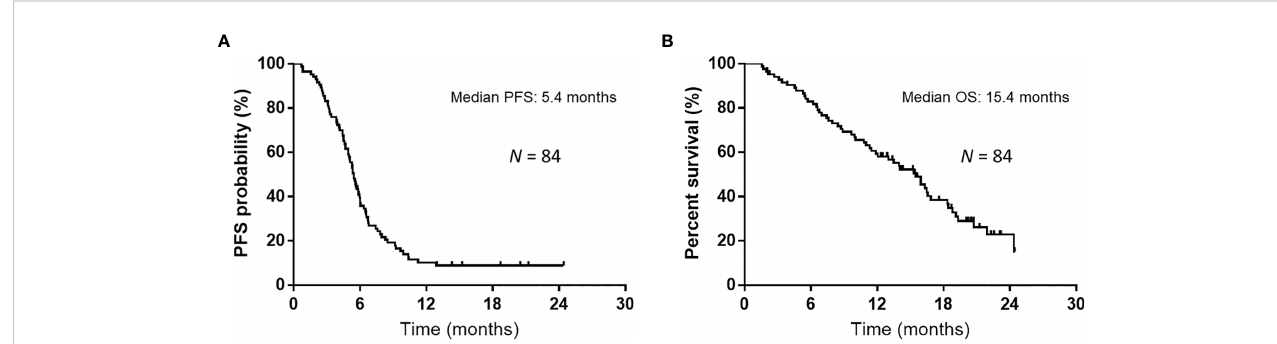
FIGURE 1 Kaplan – Meier curves for progression-free survival (PFS) and overall survival (OS). (A) The median PFS was 5.4 months among all 84 patients who received atezolizumab plus carboplatin and etoposide as fi rst-line treatment. (B) The median OS was 15.4 months among all 84 patients who received atezolizumab plus carboplatin and etoposide as fi rst-line